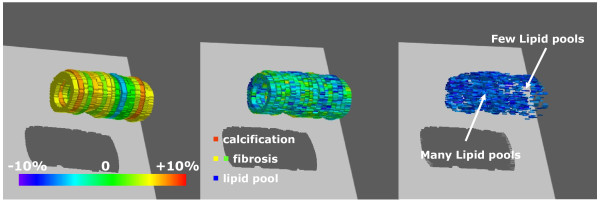
 Three-dimensional intravascular ultrasound images. (Left) Color-coded map of plaque volume response. Each color corresponded to plaque volume compression and expansion (percentage per 10 mmHg). Light green to orange signified plaque expansion, and dark green to blue indicated plaque compression during cardiac cycle. (Middle) Three dimensional integrated backscatter intravascular ultrasound (3D IB-IVUS) color-coded map that showed plaque components. (Right) 3D IB-IVUS color-coded map that depicted only lipid pool at the same lesion as the middle image. Note that plaque area response in the lesion with relatively many lipid pools (left side of the segment) was greater than that in the lesion with relatively few lipid pools (right side of the segment).